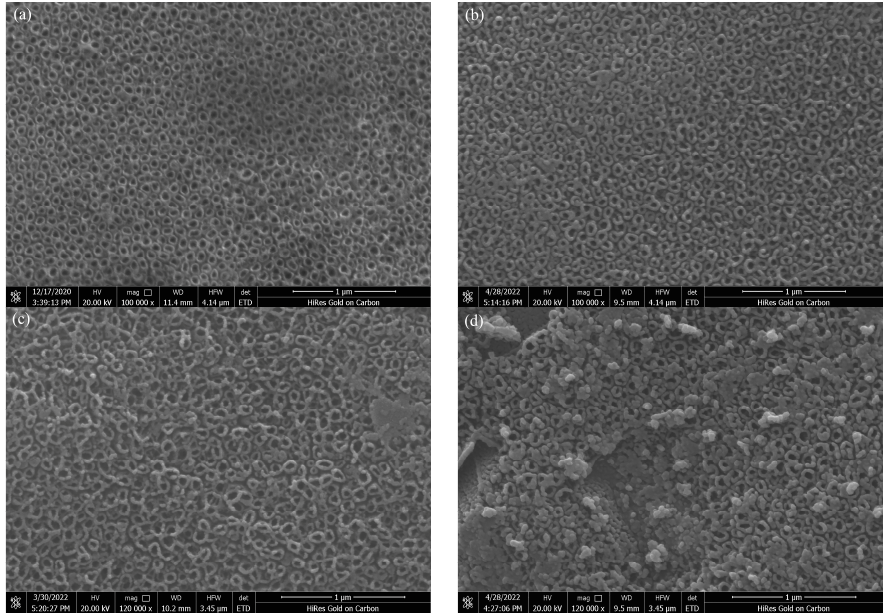
Figure 1. SEM patterns of Pt ‐ N ‐ TiO 2 nanotube electrodes with different deposition times: ( a ) TiO 2 ; ( b ) 30 min Pt ‐ N ‐ TiO 2 ; ( c ) 60 min Pt ‐ N ‐ TiO 2 ; ( d ) 90 min Pt ‐ N ‐ TiO 2 . ( b ) 30 min Pt-N-TiO 2 ; ( c ) 60 min Pt-N-TiO 2 ; ( d ) 90 min Pt-N-TiO 2